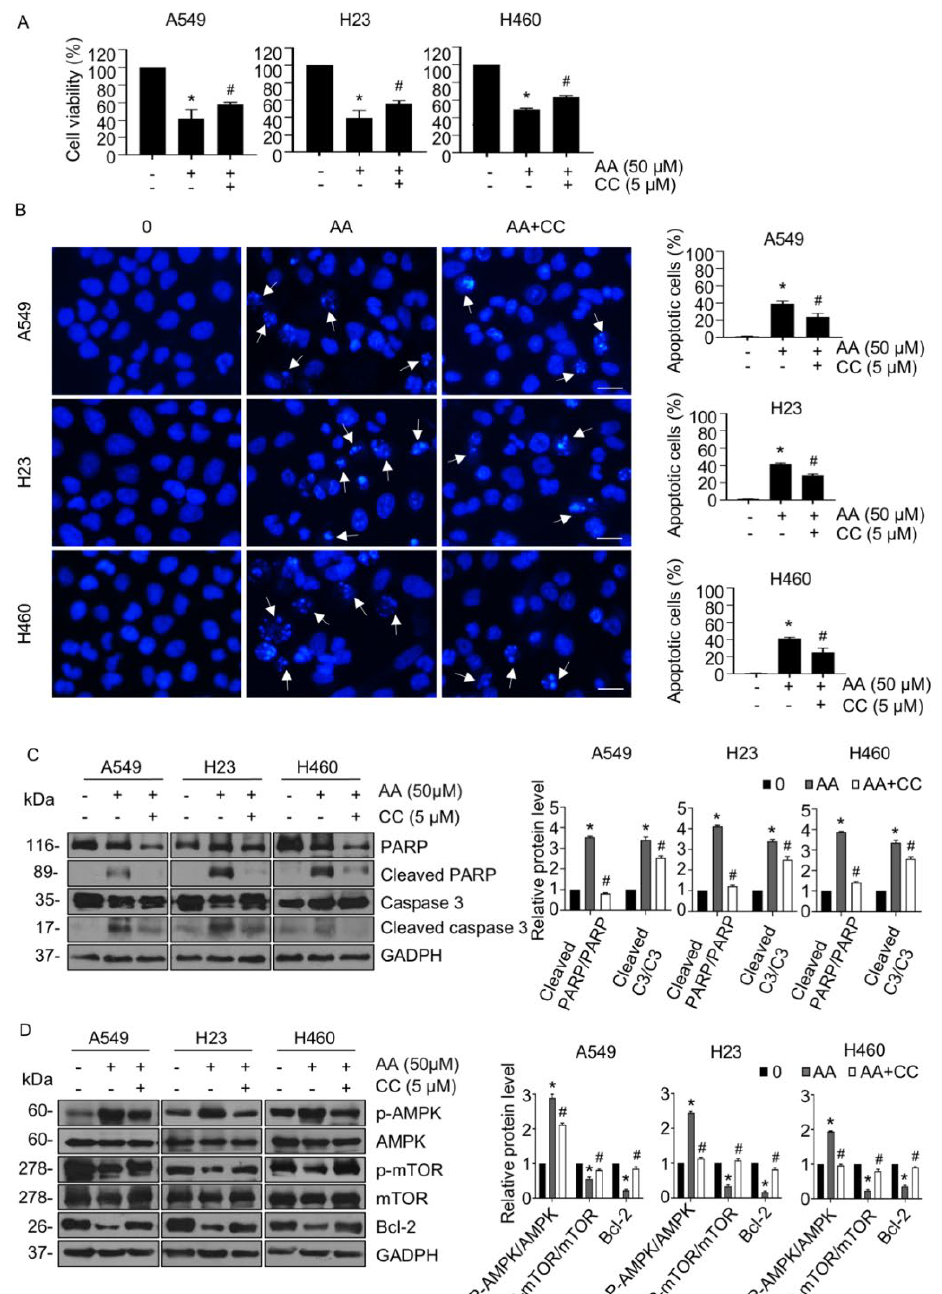
Figure 5. AMPK inhibitor attenuated aspiletrein A (AA)-induced apoptosis via AMPK/mTOR/Bcl-2 signaling. ( A ) Lung cancer cells were pretreated with compound C (CC, 5 µ M) for 30 min in the presence or absence of AA (50 µ M) for 24 h. Cell viability was determined using the MTT assay. ( B ) Apoptosis nuclei were evaluated using H33342 staining and imaged with a